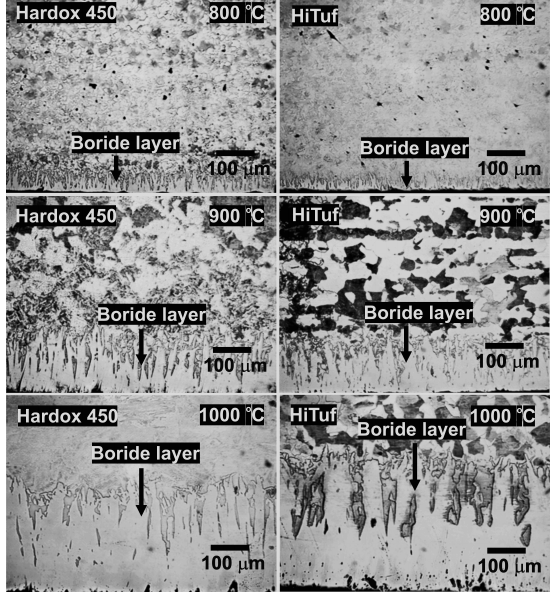
Figure 1: Optical microstructures of Hardox 450 and HiTuf steels borided at 800, 900, and 1000 ∘ C.